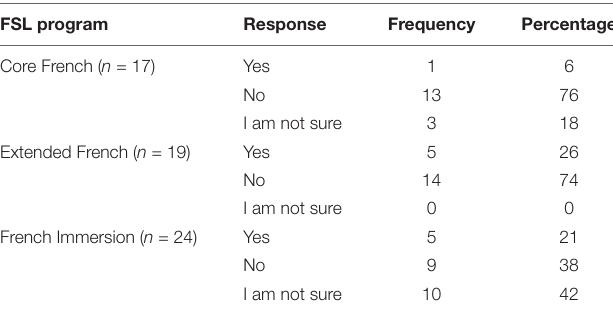
TABLE 4 | Distribution of multiple-choice responses for question 3: Are students in French programs separated from other students in the same